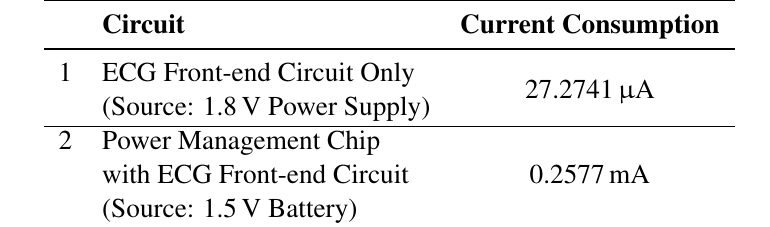
Table 5. Measured current consumption of the power management and ECG front-end circuits when supplying a regulated output voltage of 1.8 V.